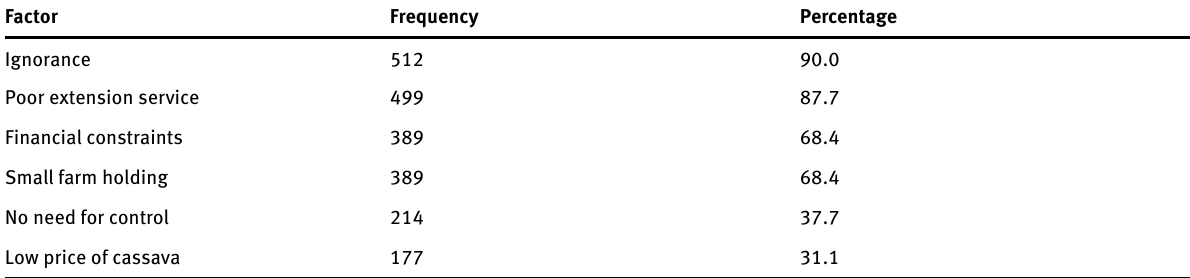
Table 8: Factor affecting farmers’ access to control measure of cassava diseases